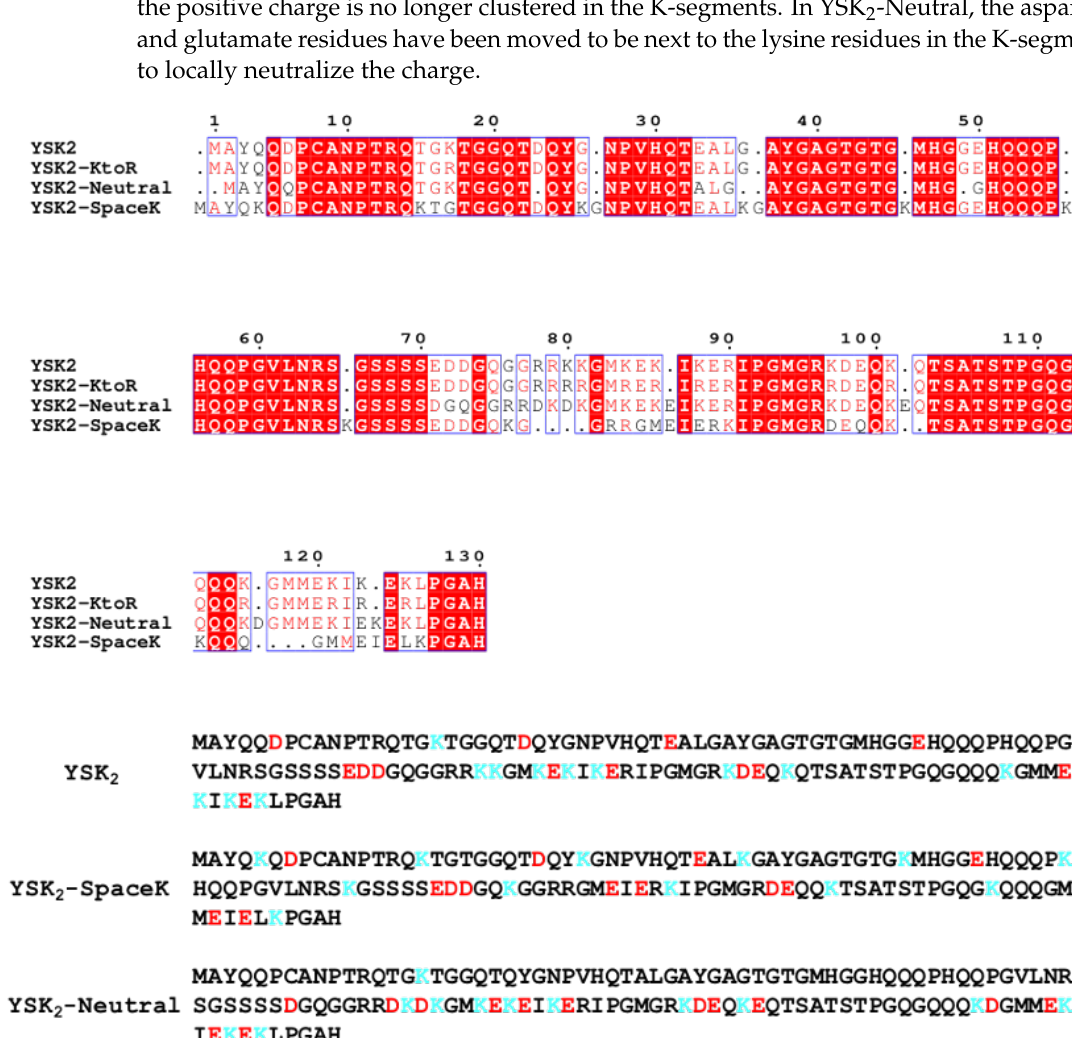
Figure 1. Sequences of wild-type YSK 2 and the three constructs. ( A ) Multiple sequence alignment of YSK 2 , YSK 2 K → R, YSK 2 -SpaceK, and YSK 2 -Neutral. The alignment was performed using ClustalW and the image was created using ESPript. Conserved regions are shown bounded by a blue box. White letters on a red background show residues conserved among all sequences, while red letters on a white background show residues that are similar. ( B ) Distribution of lysine and negatively charged residues in the YSK 2 -SpaceK and YSK 2 -Neutral constructs. All negatively charged residues are shown in red and all lysine residues are shown in